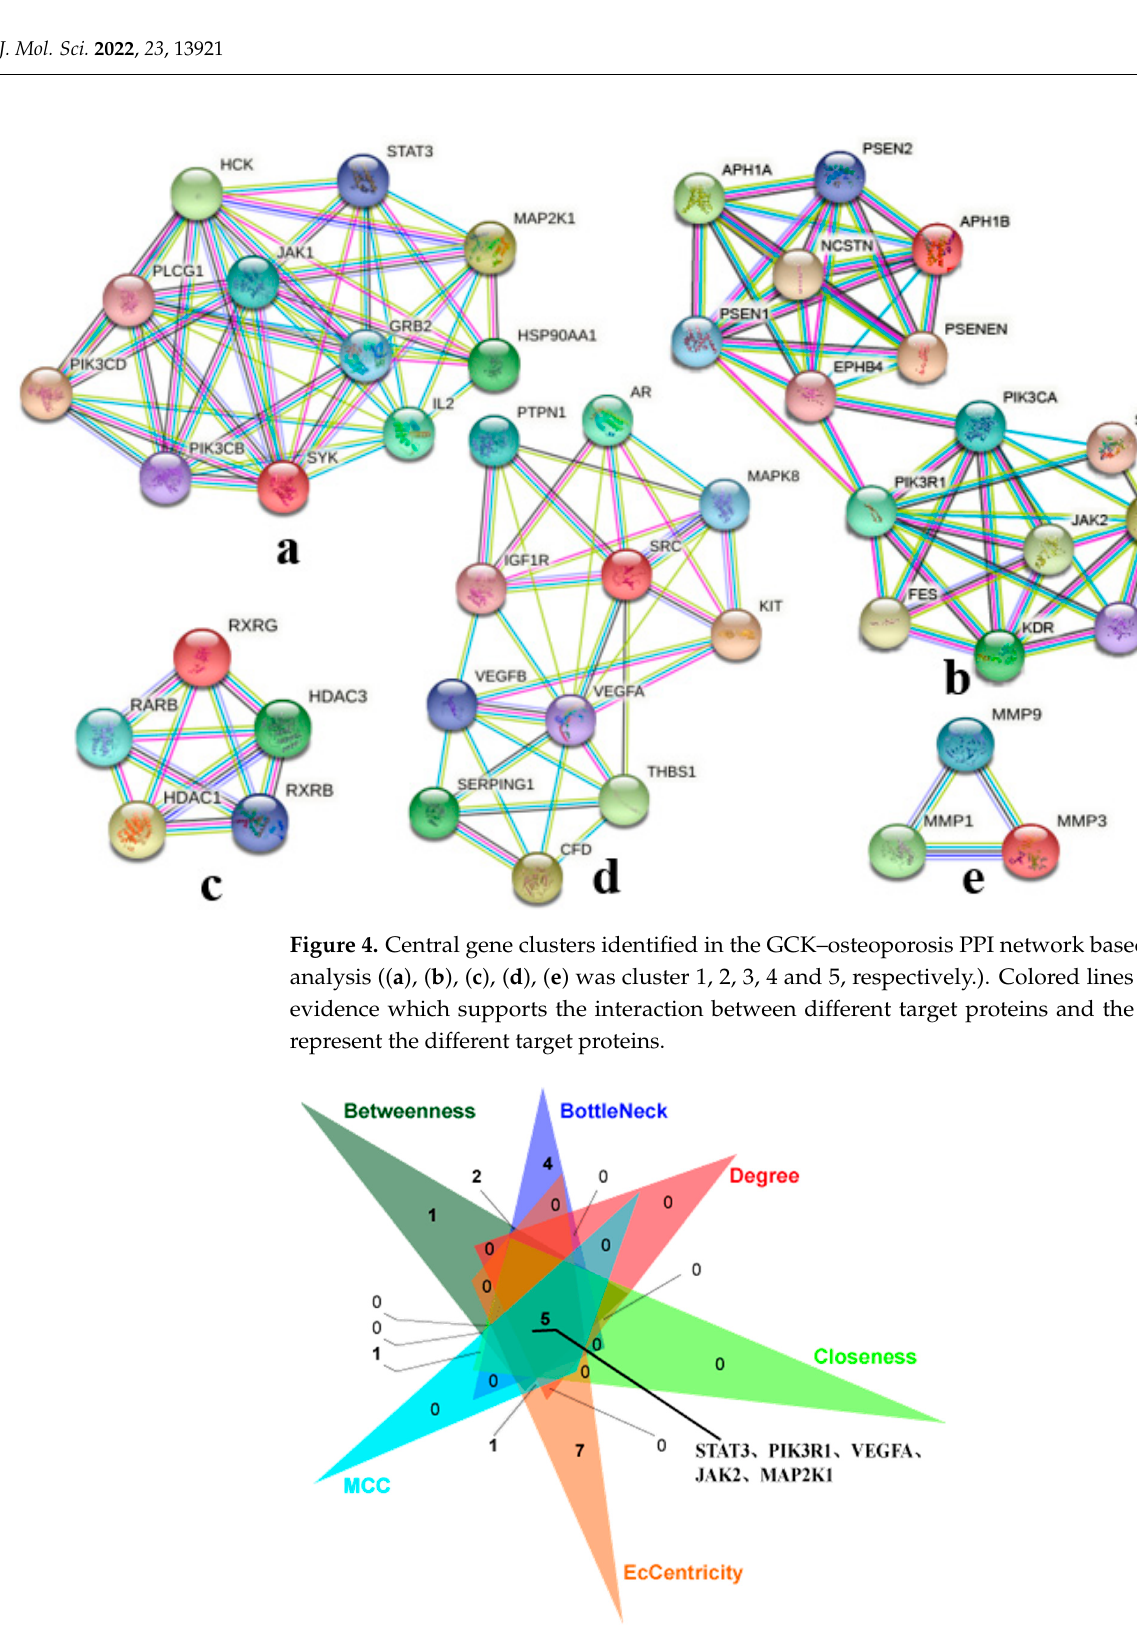
Figure 5. Key genes identified in GCK–osteoporosis PPI network based on Betweenness, Bottle- Neck, Degree, Closeness, MCC and EcCentricity method through the cytoHubba plugin of Cyto- scape software 3.8.0. Triangles with different colors represent the top 20 target proteins screened in GCK–osteoporosis PPI network through the different topological methods. In this figure, “5” rep- resents the overlap of proteins which were identified by all methods.